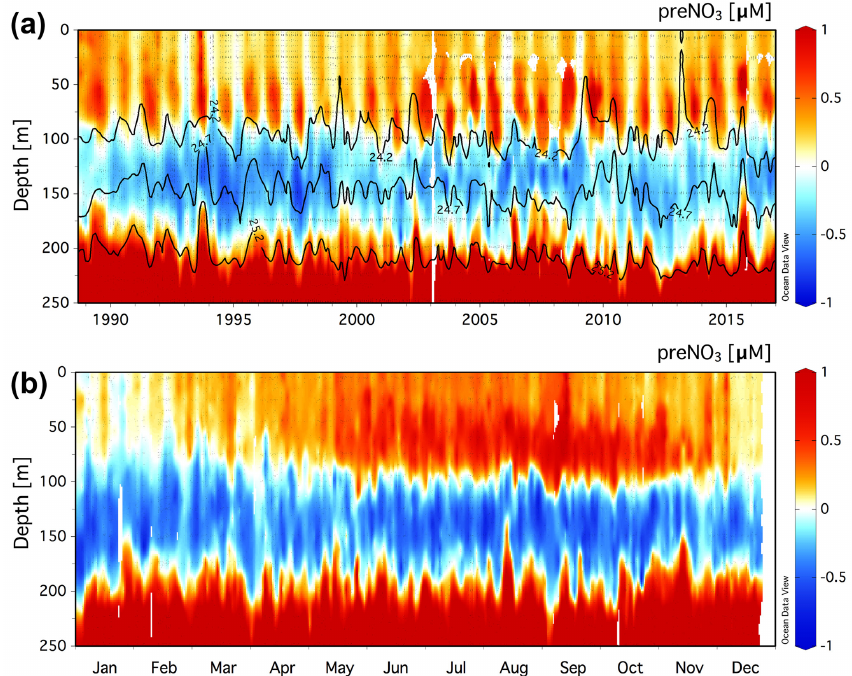
Figure 1. (a) Climatology of the residual preNO 3 tracer [µM] in the upper 250m at Station ALOHA (22.75 ◦ N, 158 ◦ W) for a value of r POM = 10 . 6. Black contour lines show neutral density, γ n = 24 . 2, 24.7, and 25.2. (b) The monthly averaged residual preNO 3 [µM] climatology for all data in the years 1989–2016.